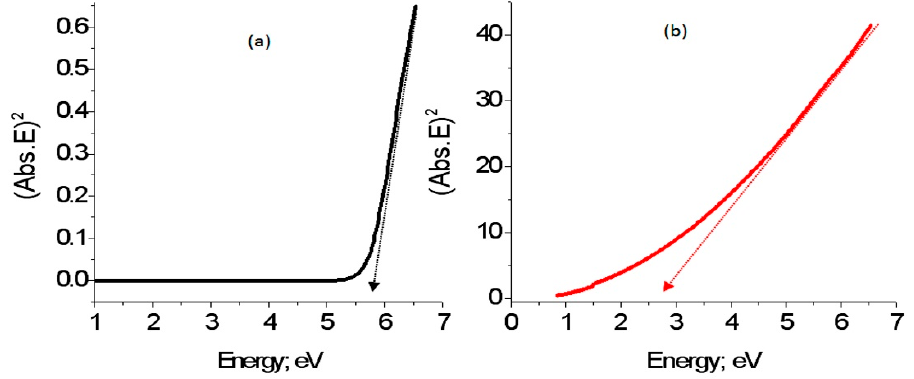
Figure 10. Absorbance spectra of ( a ) Zn-Al LDH, ( b ) Zn-Al-GO1, ( c ) Zn-Al-GO2, and ( d ) Zn-Al-GO3.